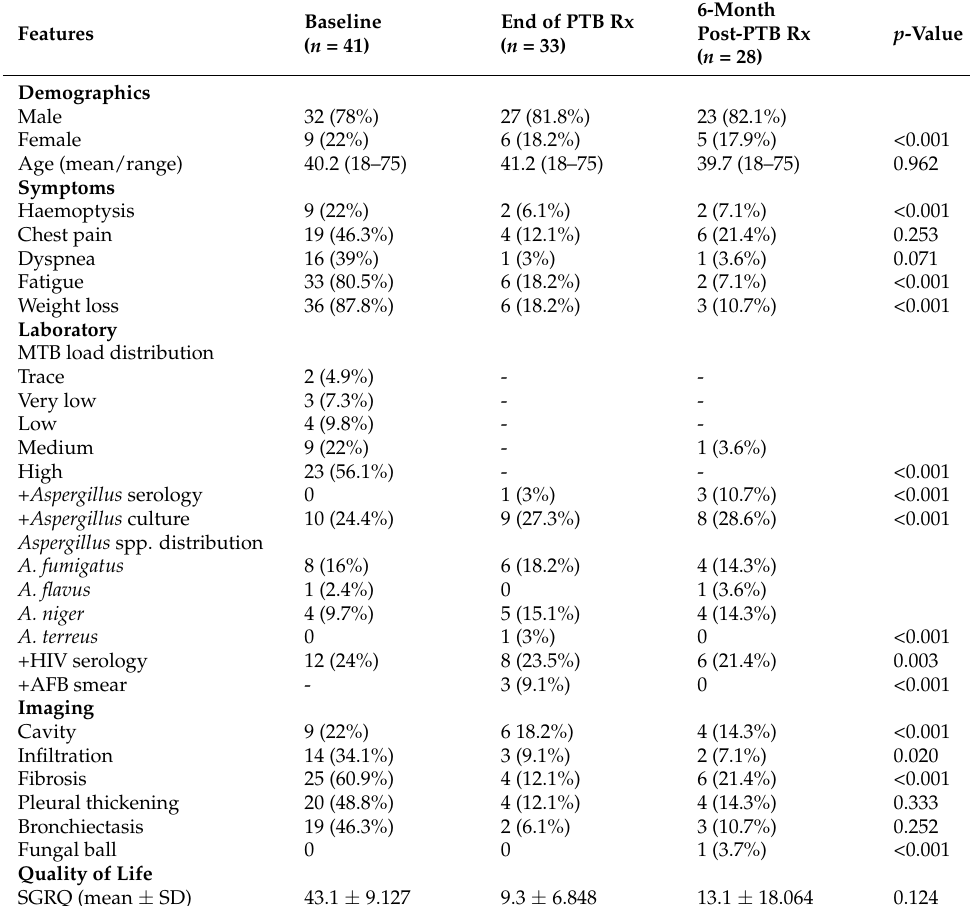
Table 1. Patients’ characteristics at the three time points.